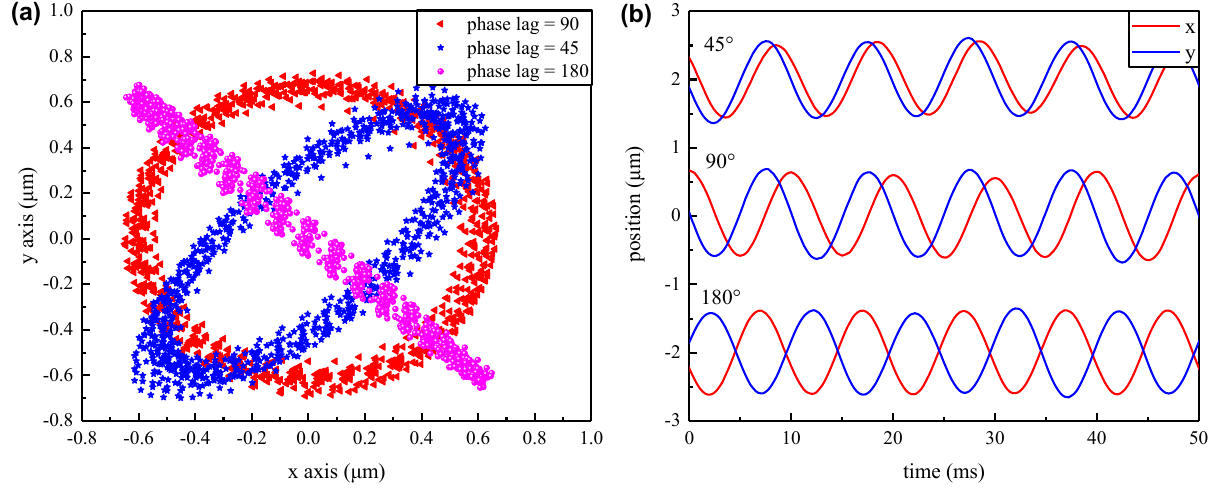
Figure 3: Experimental results showing flexible control of the orbital trajectories of various phase lags in the x and y signal. (a) COM position distribution in the x – y plane. (b) COM position along x and y direction in time